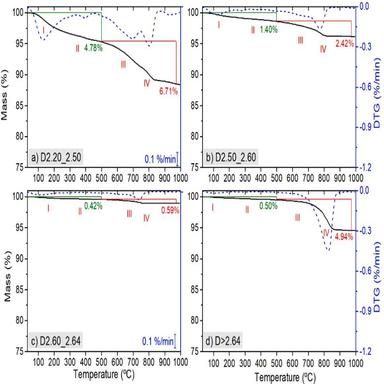
TGA-DTG curves of density products of fine recycled concrete aggregates (low carbonate content sample).